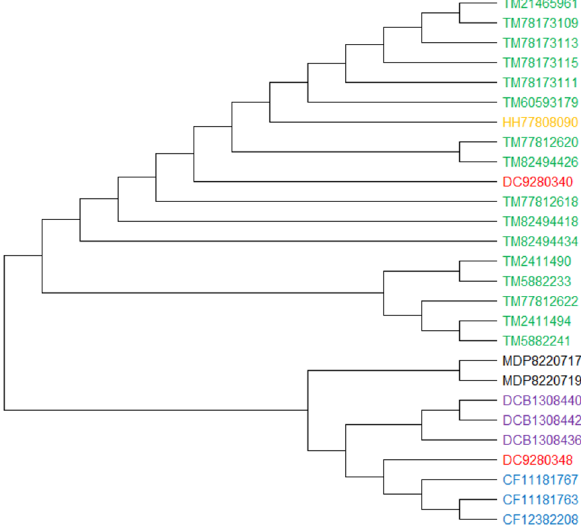
Figure 12. 27 Antifreeze proteins (AFPs) sequences constructed by our method (NJ).